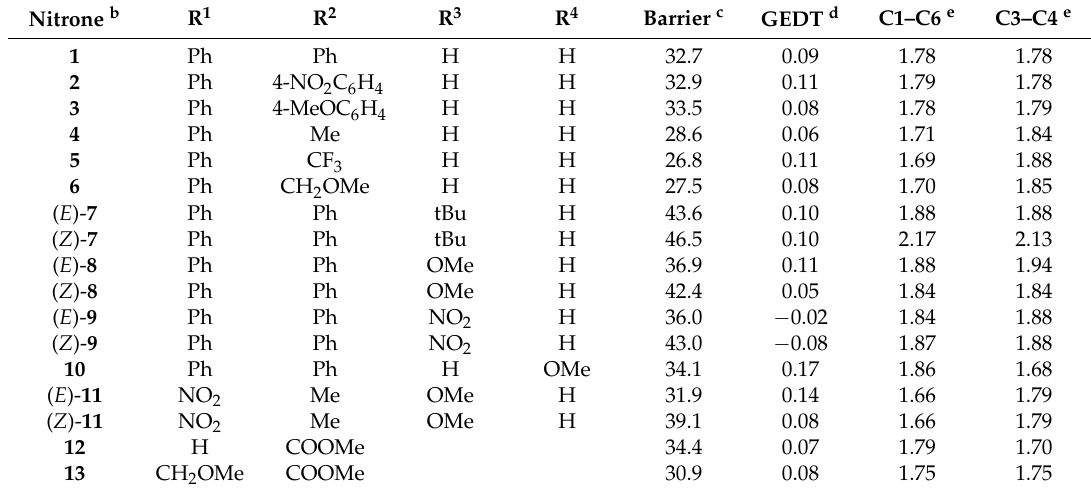
Table 1. 2-Aza-Cope rearrangement of γ -Alkenyl Nitrones a . Nitrone